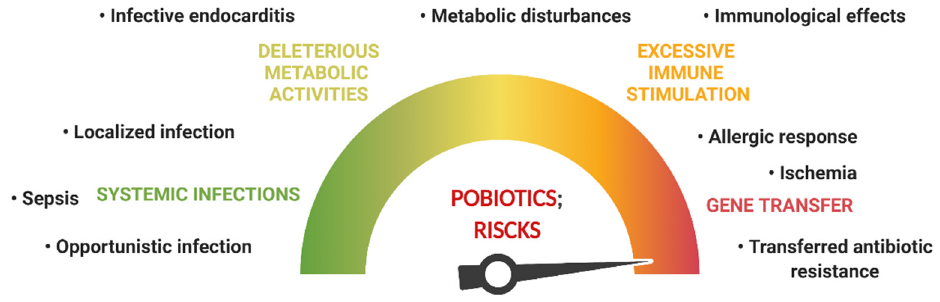
Figure 1. Possible risks caused by